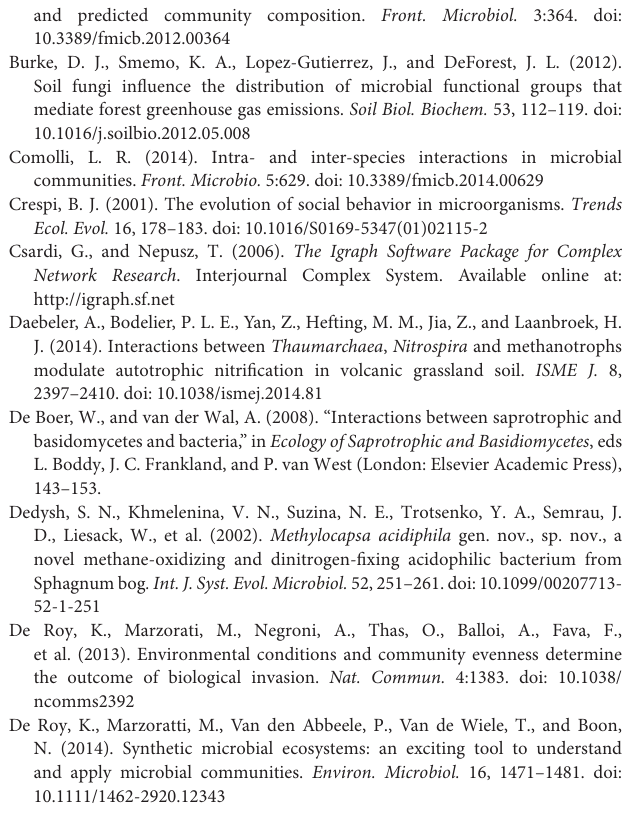
Figure S3 | Network analysis of 16s rRNA gene sequences derived from the “heavy” fraction of a 13 C-CH 4 labeled community in a grassland soil (Daebeler et al., 2014). The correlating OTUs with >1% relative abundance are given in the figure, and the corresponding taxonomic affiliation are listed in the Supplementary Information ( Table S3 ).